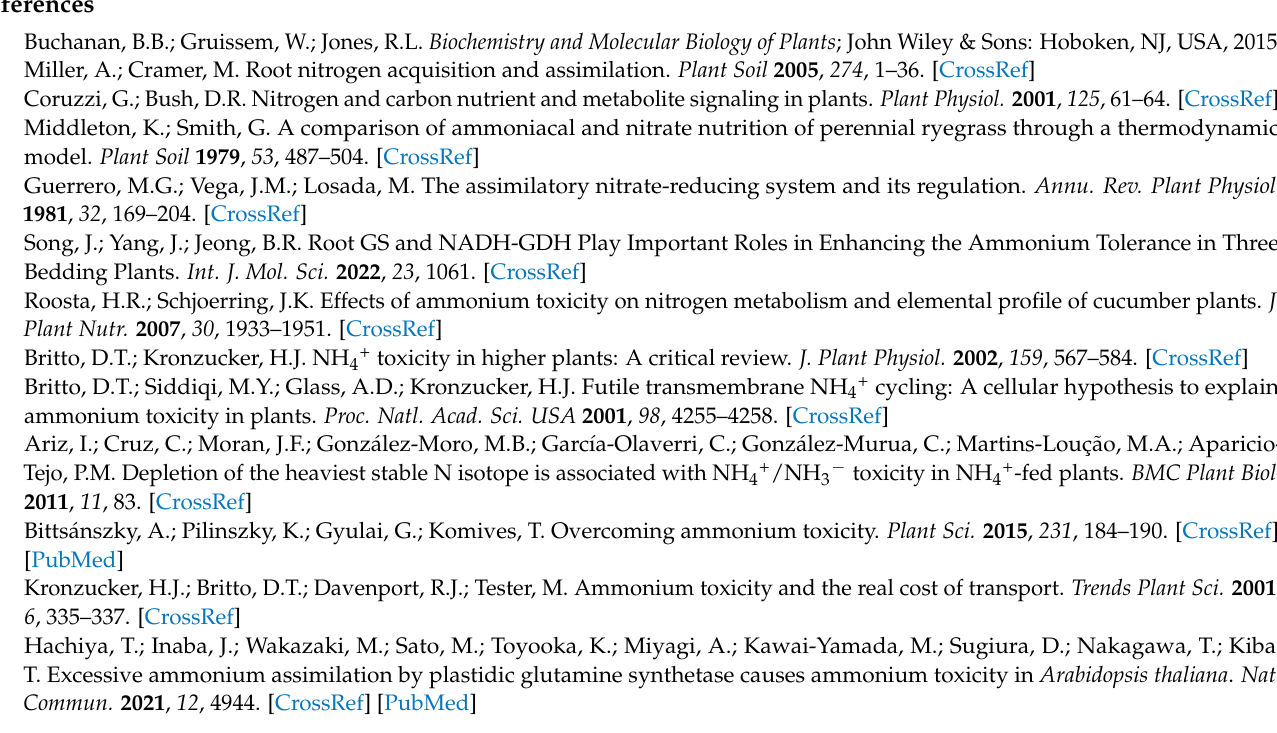
Figure S2: The Mg 2+ content changes in three NH 4+ :NO 3 − hydroponic solutions supplied for ( A ) the control (without plants); ( B ) salvia; ( C ) petunia; ( D ) ageratum; ( E ) cabbage; and ( F ) lettuce. Data are means ± SD representing n = 3 biological replicates. Columns accompanied by different lower case letters were regarded as significantly different, according to the one-way ANOVA following the Duncan’s multiple range test at p =